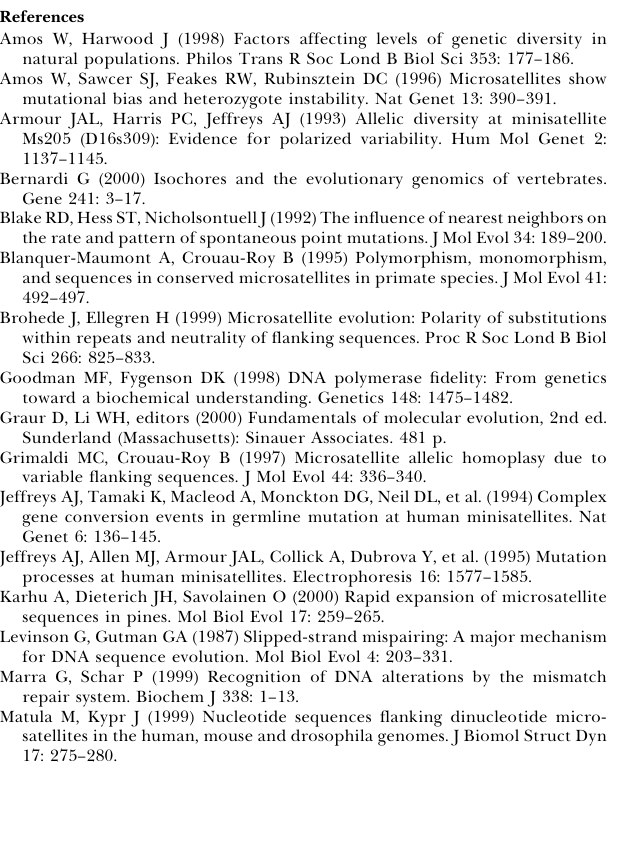
Figure S2. Flanking Sequence Frequency Distributions for Four Dinucleotide Motif–Cassette Combinations Further to Those Shown in Figure 4 Plots are as described in Figure 4. Figure S3. Dinucleotide Flanking Sequence Patterning in Inter- spersed Repeats and Unique Sequence DNA Figure depicts equivalent patterns of asymmetry in AT dinucleotide frequencies for the commonest cassette type, (T/A), around micro- satellites in unique sequence DNA (A), LINE/L1 elements (B), and SINE/Alu elements (C). Plotting conventions are the same as for Figure 4. Figure S4. Dependence of Differences among Homologous Loci on Location of Microsatellite Block position is relative to the central microsatellite (not shown). (A and B) Proportion of exact matches (with 95% binomial confidence intervals) and average number of matches, excluding exact matches ( 6 standard error), with block position around (AC) 2–3 microsatellites ( n = 4,593). (C and D) As (A and B) but for (AC) 4 þ microsatellites ( n = 356). Average proportion of exact matches and number of matches, calculated separately for 5 9 and 3 9 blocks around (AC) 2–3 micro-